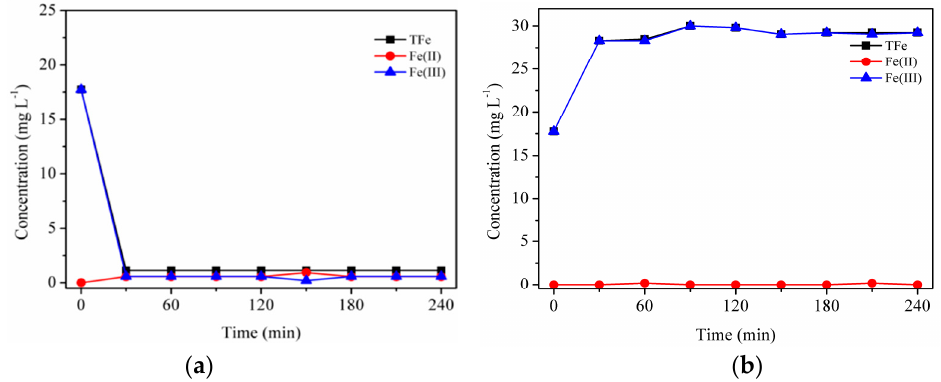
Figure 3. Dissolution kinetics with suspensions of 0.1 g L − 1 Fhy at pH 3.0 ( a ) under UV illumination and ( b ) in the dark in the presence of 1.0 mM oxalic acid.